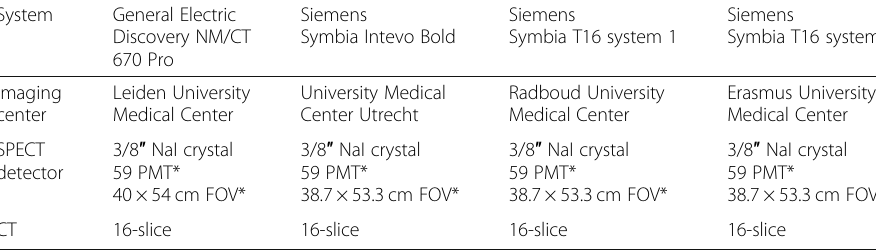
Table 1 Main properties of the dual headed SPECT/CT systems used in this study System